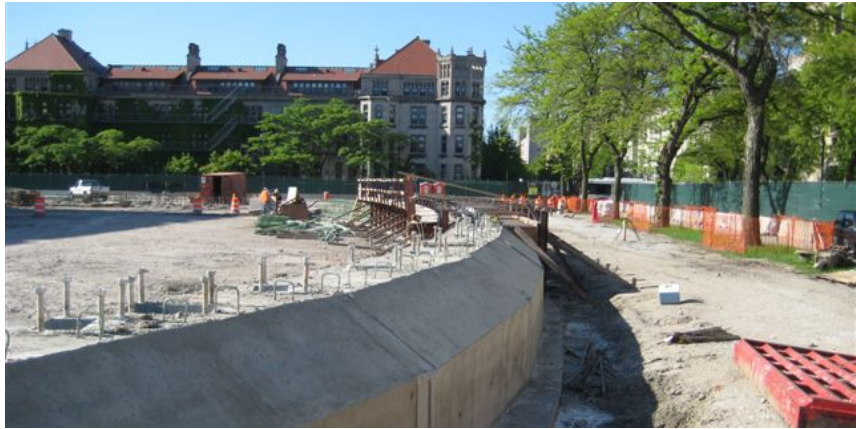
Figure 10: The site in spring 2009 – construction of the ring beam (© Werner Sobek Stuttgart).